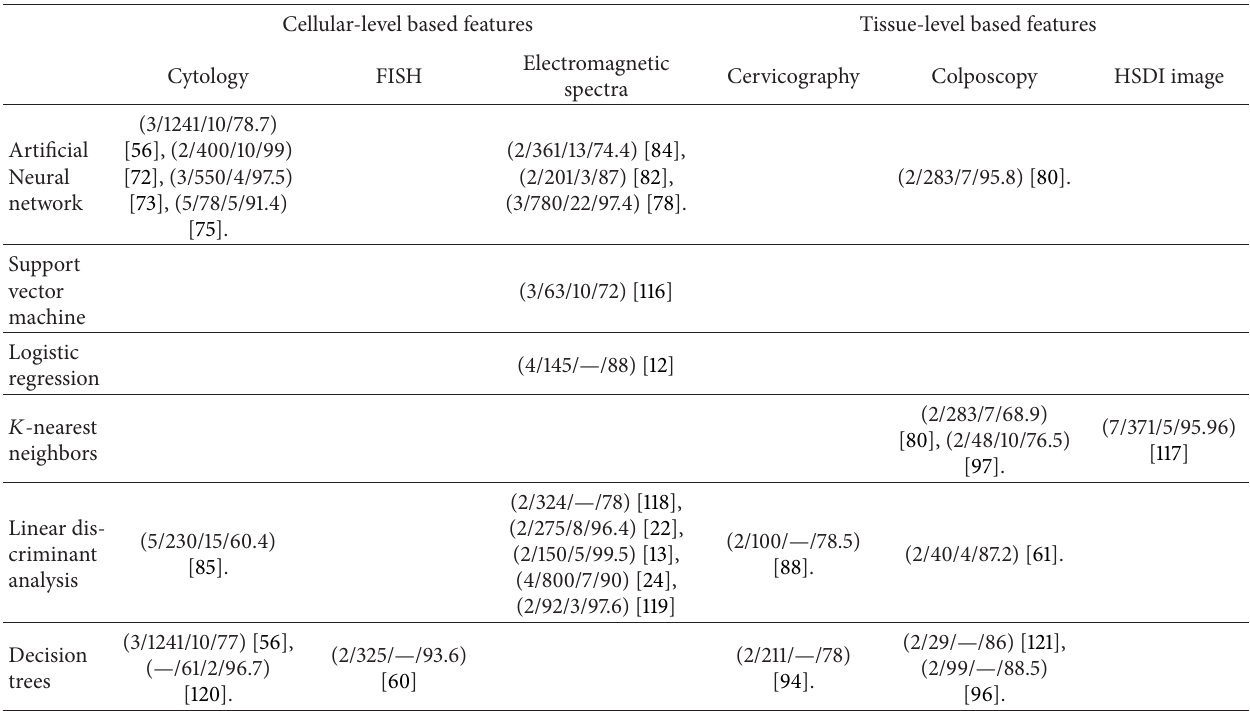
Table 4: The list of classifiers that are used by different